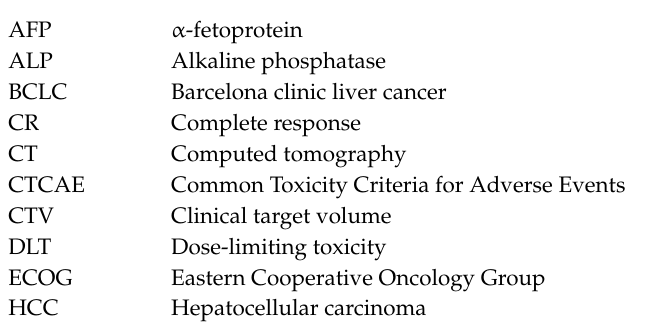
Figure S1: Protocol scheme for the current Phase I study, Figure S2: Progression-free survival and overall survival of all patients ( n = 17), Table S1: Dose escalation schedule, Table S2: Normal tissue radiation dose